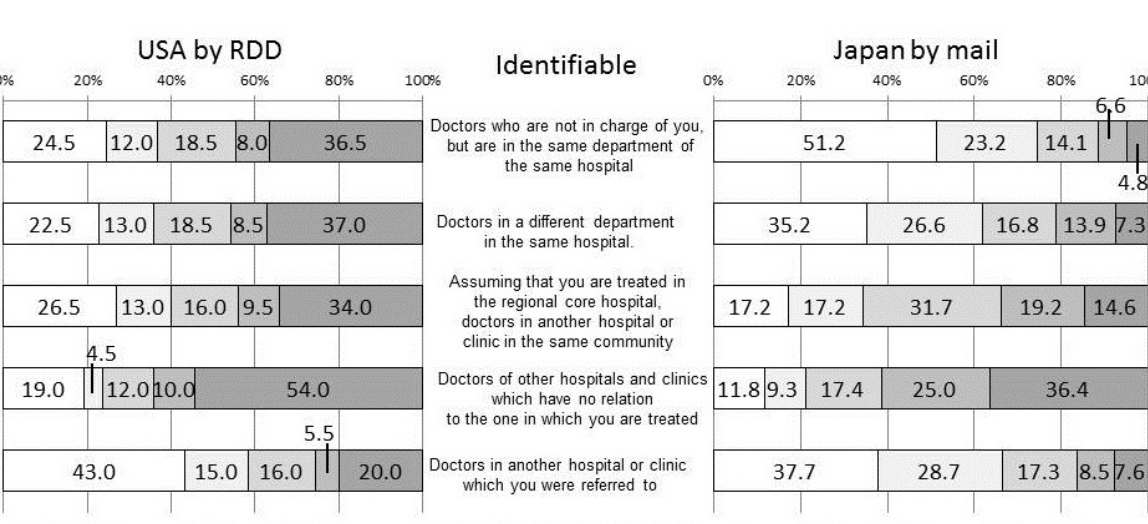
Figure 1. How would you feel if, without your consent, your medical records were disclosed to these doctors/organizations in an identifiable manner?